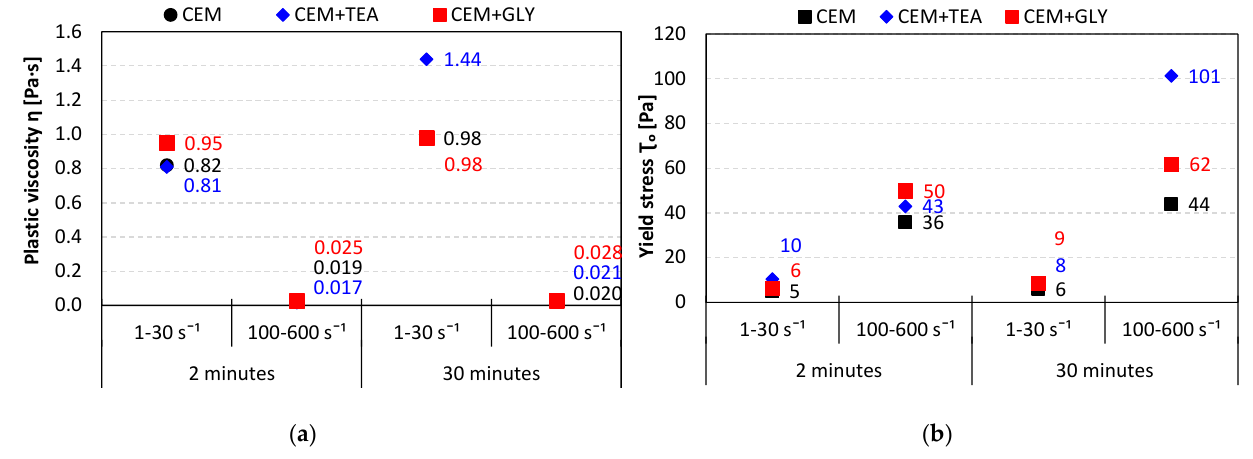
Figure 10. ( a ) Plastic viscosity and ( b ) yield stress of pastes without superplasticizer; w/c = 0.6. Flow curves were also measured for pastes containing 0.8% of superplasticizer in re- spect to the mass of cement, characterized by a lowered w/c ratio, equal to 0.4. Figure 11a,b